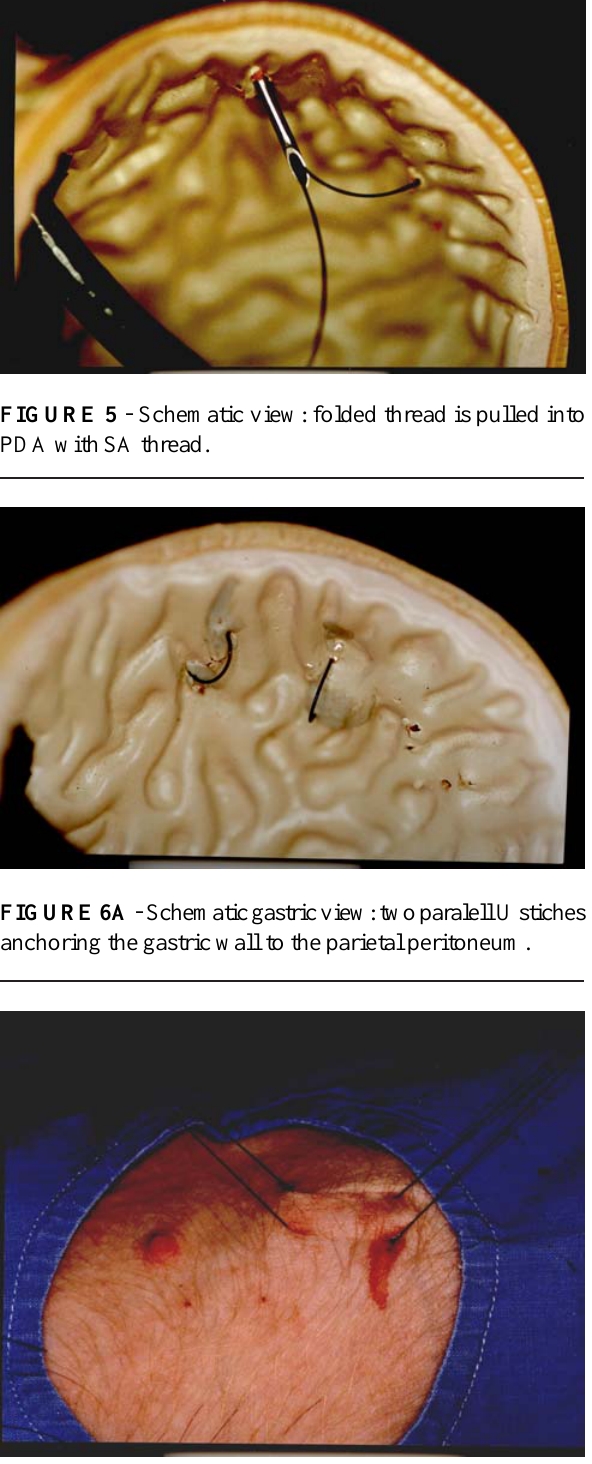
FIGURE 6B - Surgery external view: two parallel U stiches anchoring the gastric wall to the parietal peritoneum.